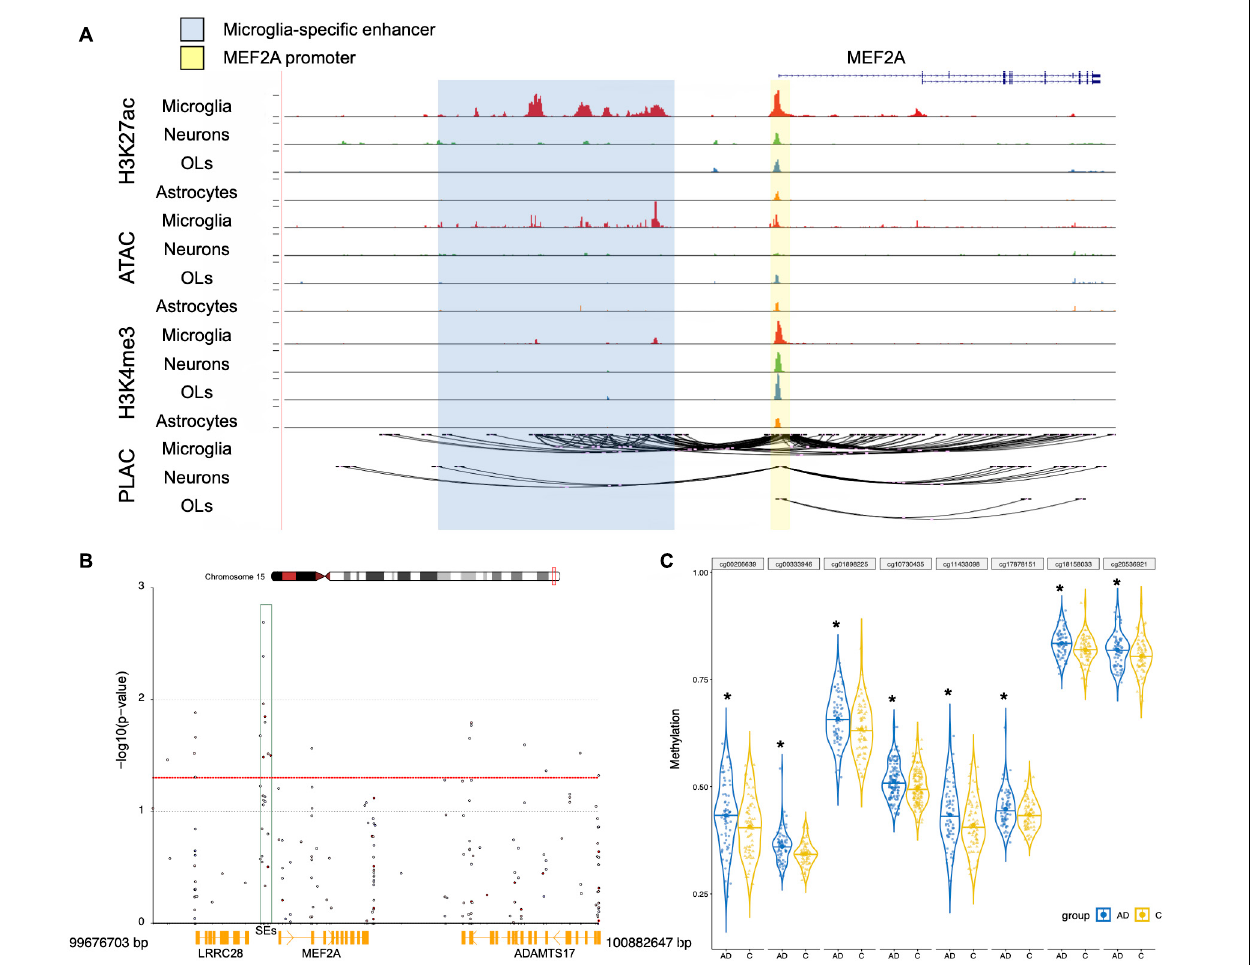
FIGURE 6 | Epigenetic regulation analysis of MEF2A expression. (A) UCSC browser of the MEF2A locus showed ATAC-seq, H3K27ac and H3K4me3 ChIP-seq, and PLAC-seq in brain cell types, including neurons, microglia, astrocytes, and oligodendrocytes (OLs). Shared active promoter region is indicated in yellow; microglia-specific enhancer region is indicated in blue. (B) The DMPs range around MEF2A, approximately 99,676,703–100,882,647 bp of chromosome 15, was used to create a Manhattan plot by coMET package of the R software with a threshold p -value of 0.05 (shown as red dotted line). The -log10( p -value) of DMPs for MEF2A in dataset GSE80970 (Smith et al., 2018) were shown in the Manhattan plot. The SEs region is shown as a green box. (C) The methylation levels for eight DMPs of the enhancer region in AD and healthy people were shown using GraphPad, and a Student’s t -test was used for comparisons across groups. * p < 0.05 compared with the control